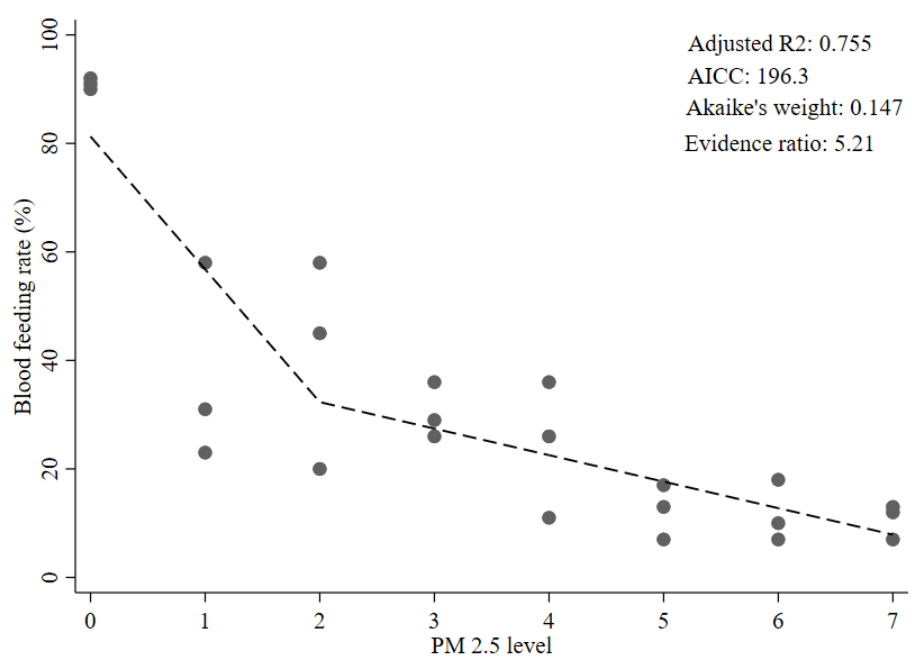
Figure 2. Two-segment piecewise linear model of the dose–response relationship between PM 2.5 level and blood-feeding rate in female Ae. aegypti mosquitoes .